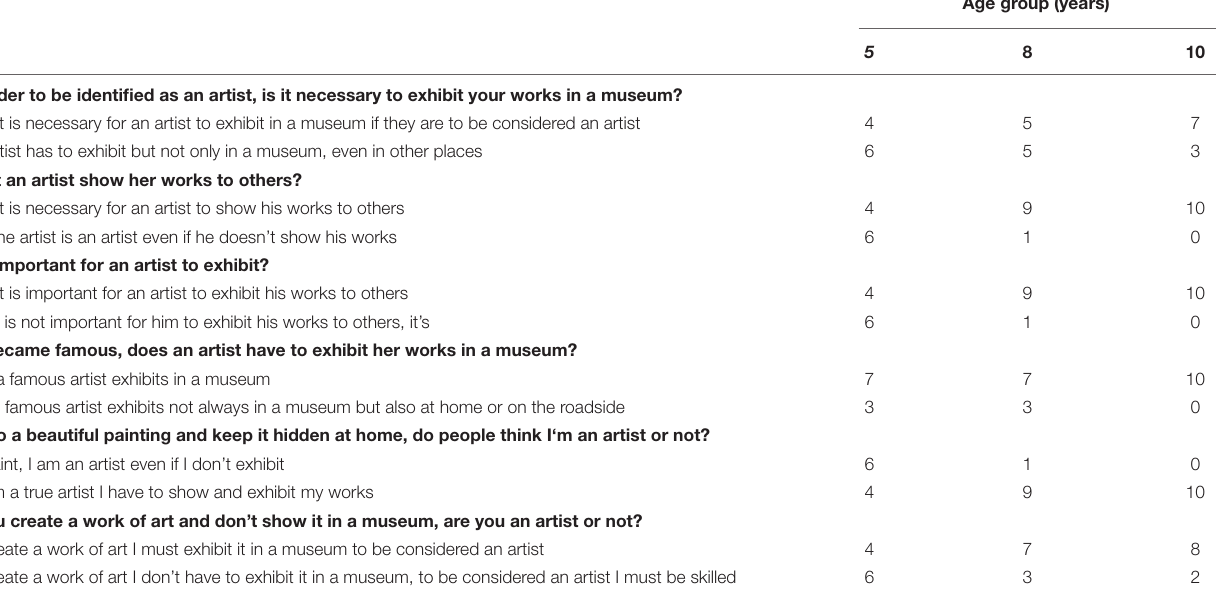
TABLE 1 | Frequency of answers in Study